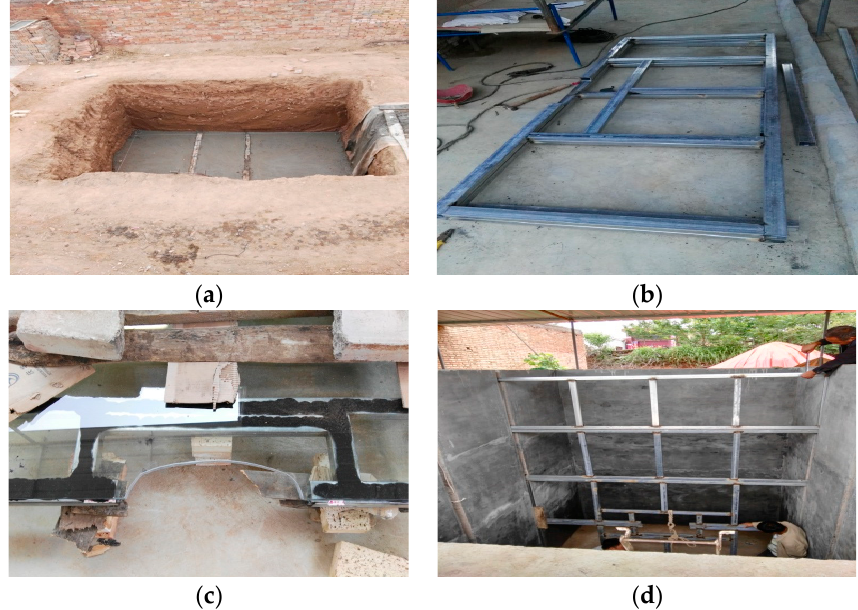
Figure 2. Fabrication of model groove: ( a ) Test trench; ( b ) Pit side support frame; ( c ) Glass retaining wall; ( d ) Frame support Figure.